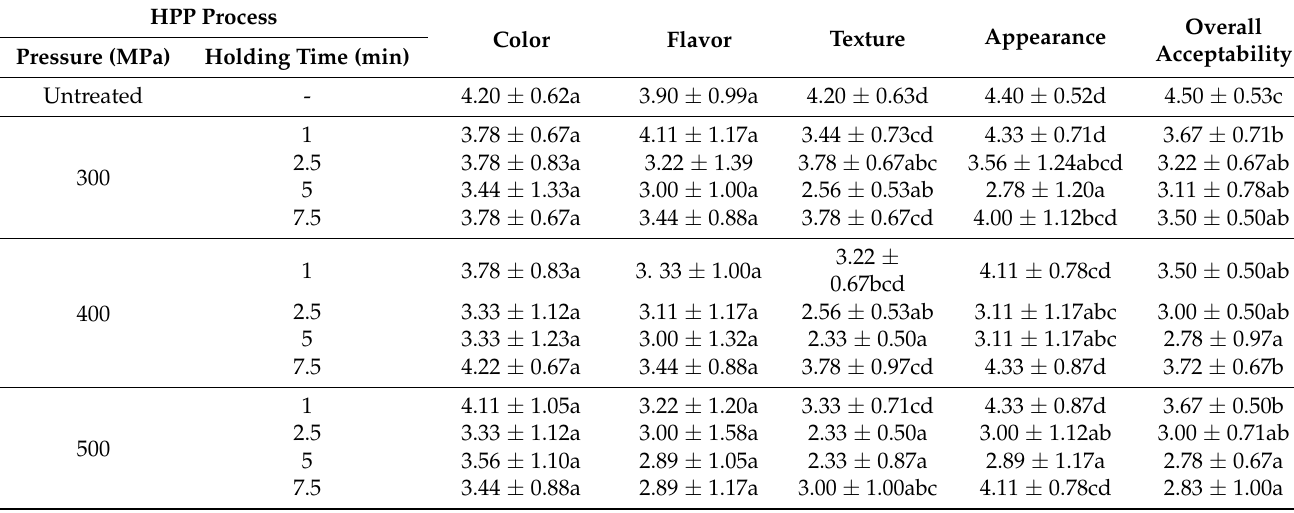
Table 1. Sensory evaluation of fresh-cut peppers by high-pressure processing (HPP) treatment. HPP Process Color Flavor Texture Appearance